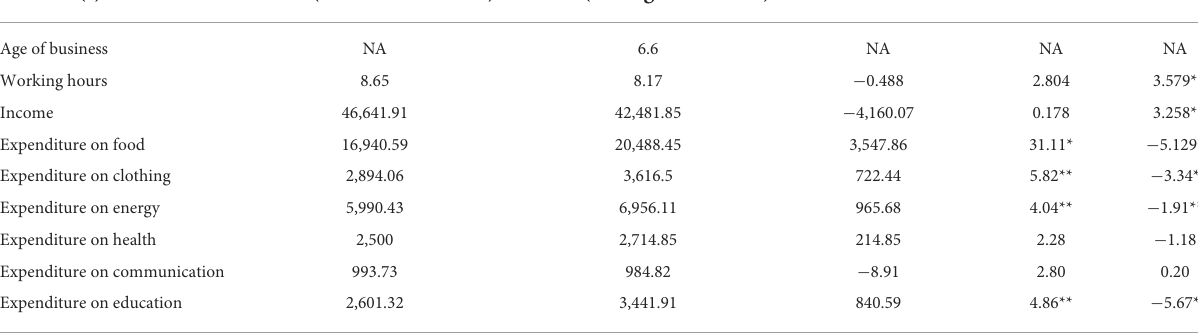
TABLE 3 Mean differences before and during COVID-19.